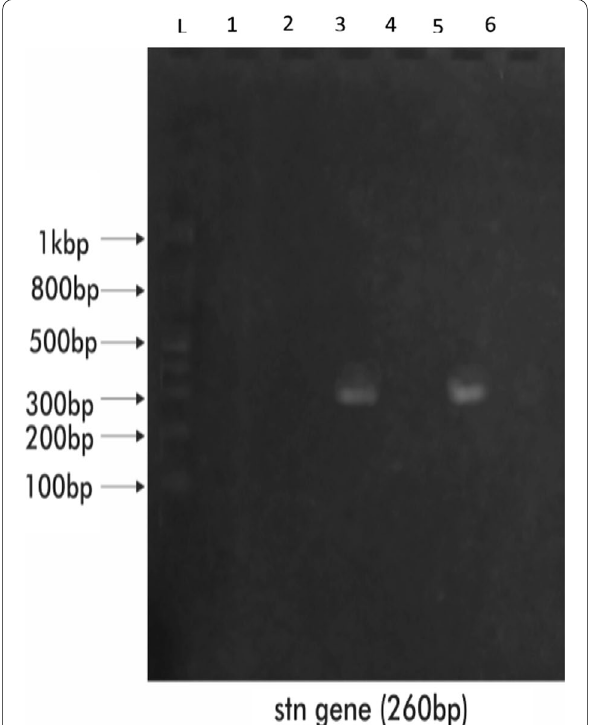
Fig. 4 PCR amplification of genomic DNA targeted to amplify the Stn virulence factor embedded in Salmonella enterica serovar typhimurium on 1.0% agarose gel electrophoresis. L Molecular = Marker. 1 A1, 2 A6, 3 A8, 4 IK2, 5 IK3, 6 W2 = = = = = =